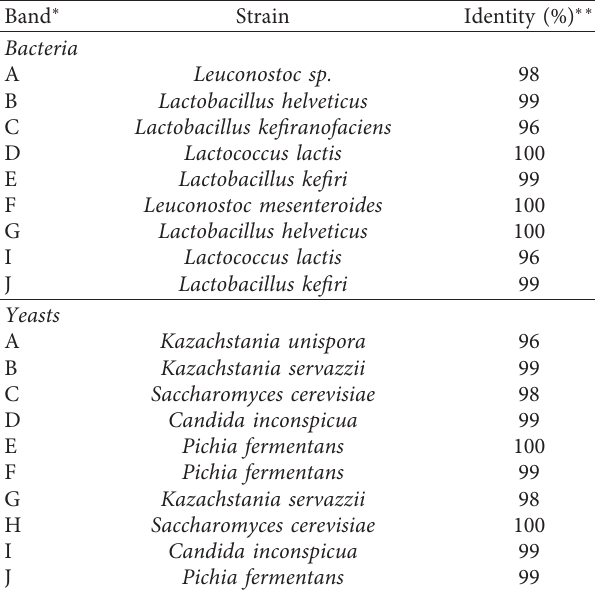
∗ Bands are numbered as indicated in the DGGE profiles shown in Figure 3. ∗∗ The result of the sequence of the recovered bands was consistent with the recent standard strains in GenBank database (http://www.ncbi.nlm.nih.